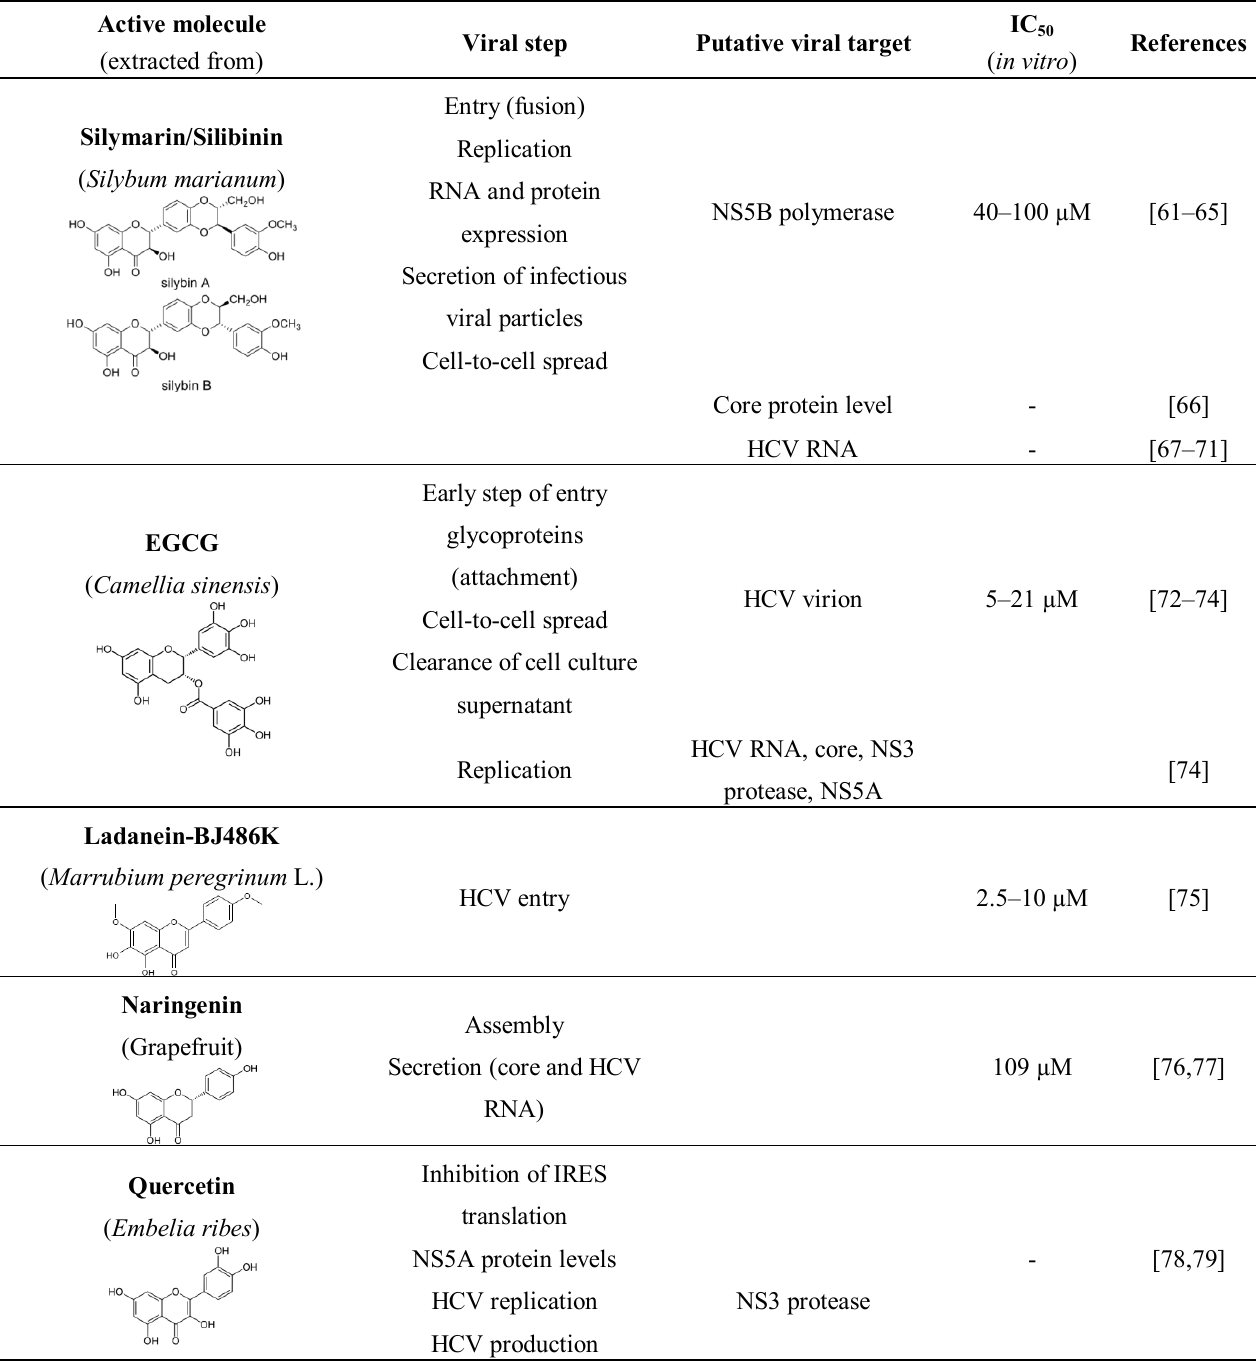
Table 1. Natural molecules with anti-HCV activities tested in vivo or in cellular models. Active molecule (extracted